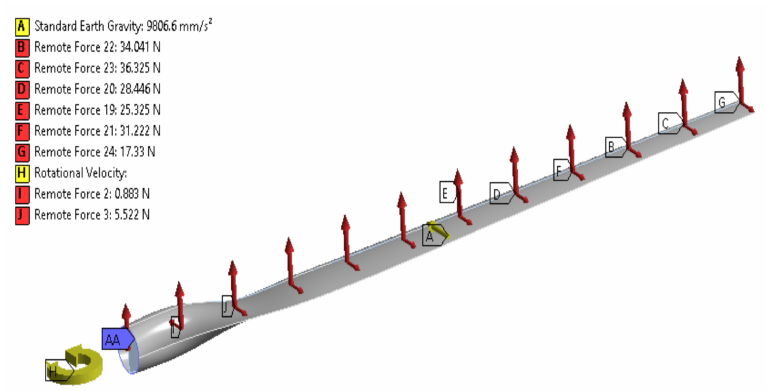
Figure 6. Boundary conditions and applied